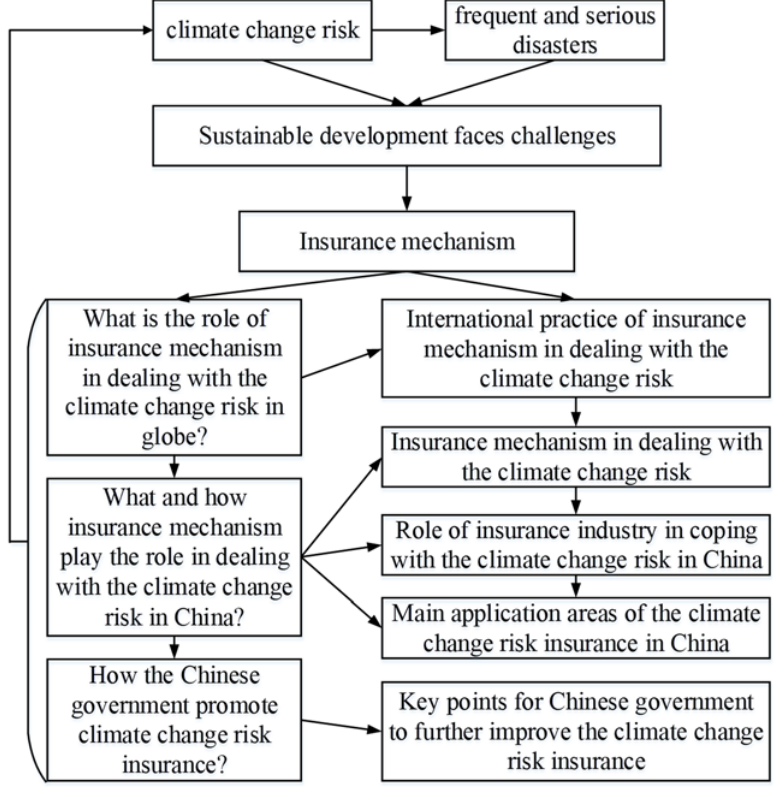
Figure 1. Insurance mechanism and climate change risk.